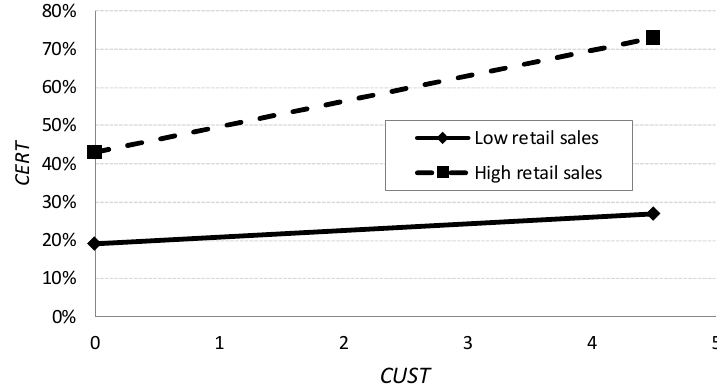
Figure 4. Interaction effects DIST × CUST. Notes: CERT is the percentage of certified production sold by the wholesaler; CUST is the degree of customer requirements, where 1 is lowest and 5 is maximum; DIST is the percentage of sales carried out through big retailers.